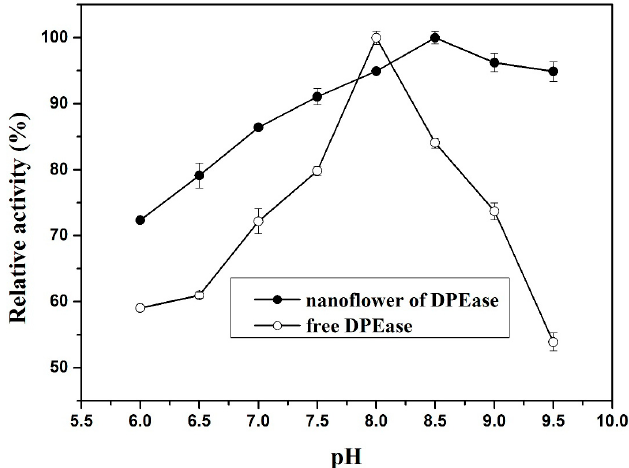
Figure 5. Effect of pH on nanoflower and free DPEase. The pH range was 6.0–9.5. The enzyme activities at a pH of 8.5 for nanoflower (36.2 U/mg) and at a pH of 8.0 for free DPEase (5.0 U/mg) were both 100%.